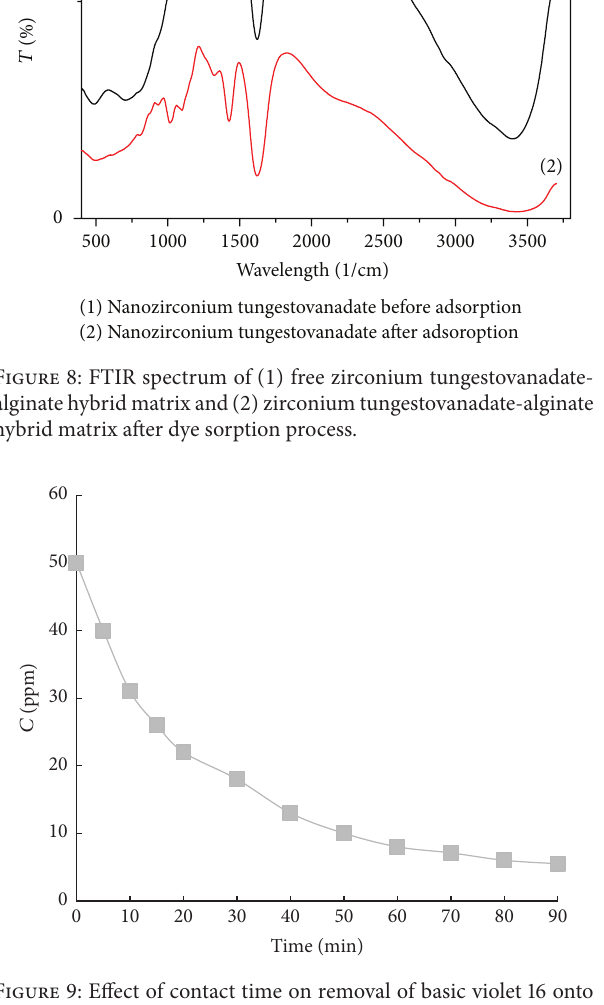
Figure 9: Effect of contact time on removal of basic violet 16 onto composite sheet matrix (initial dye conc. = 50ppm; immobilized zirconium tungestovanadate dose = 0.1g; solution volume = 25 mL, temperature = 25 ± 2 ∘ C; pH = 6; agitation speed = 200